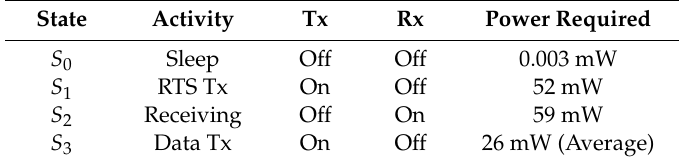
Figure 4. The transmission energy per bit for a four antennas DIFS-VSDH-MAC protocol showing the proportion of energy used by DIFS (DCF Interframe Space) carrier sensing. Table 2. Operational states for Finite State Machine (FSM) of sensor nodes.